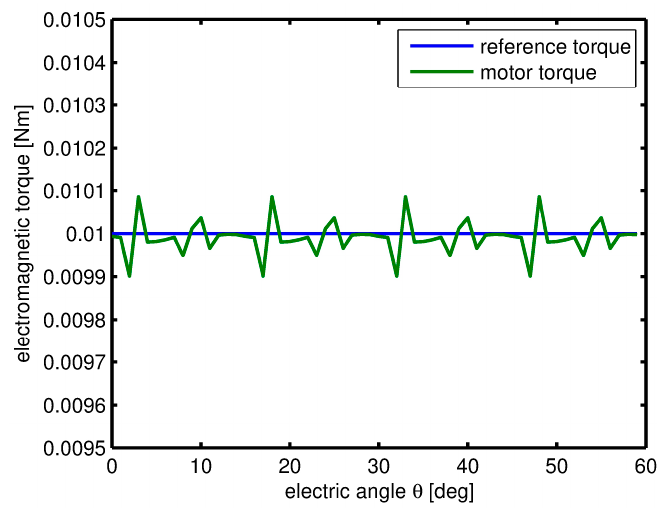
Figure 7. Voltage waveform for the TSF method with an exponential current waveform. Energies 2017 , 10 , 799